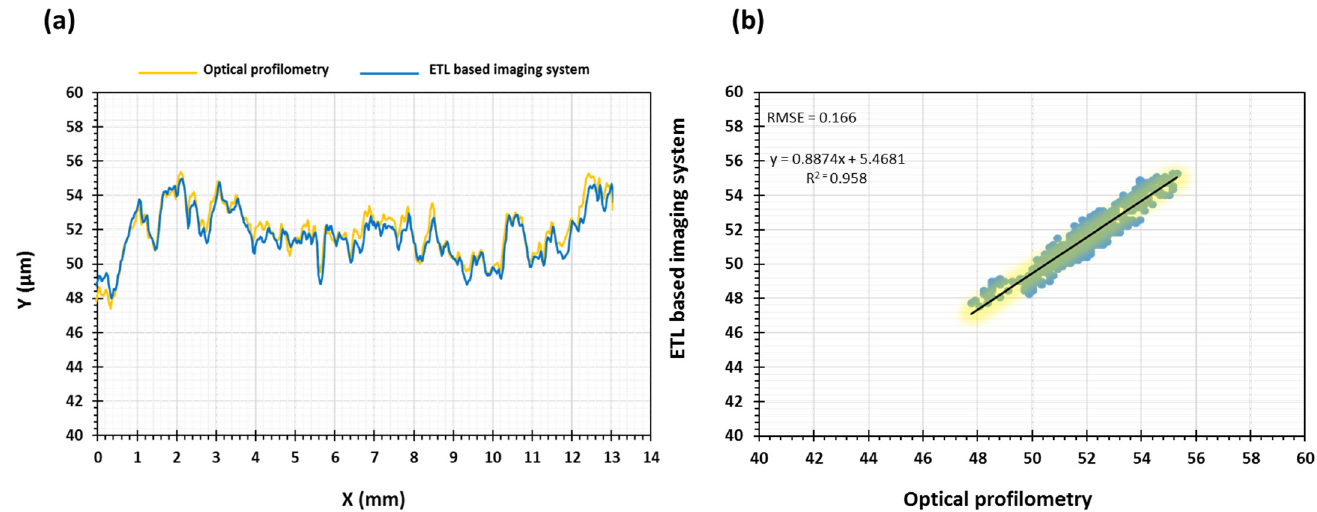
Figure 7. ( a ) 2D line scans of the tablets generated using a line passing through the exact centre point of the pharmaceutical tablet images generated using optical profilometry and newly developed ETL-based imaging system and ( b ) quantitative comparison by determining the root mean square error (RMSE) of the 2D line scan data points.